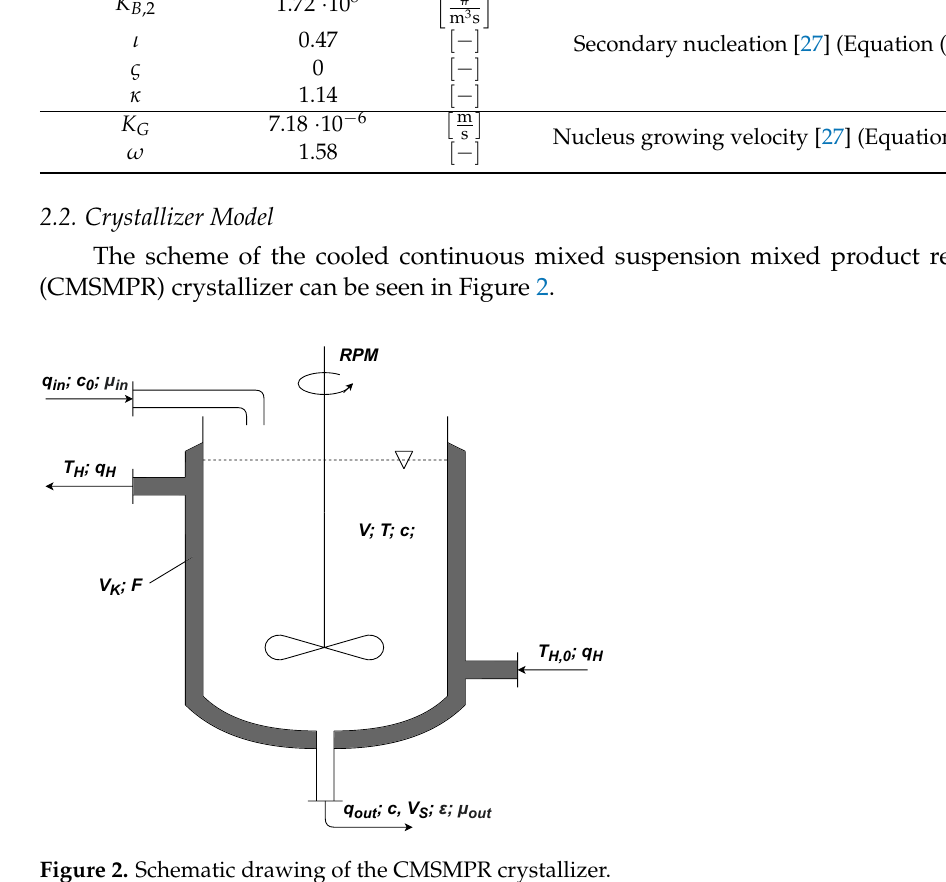
Figure 2. Schematic drawing of the CMSMPR